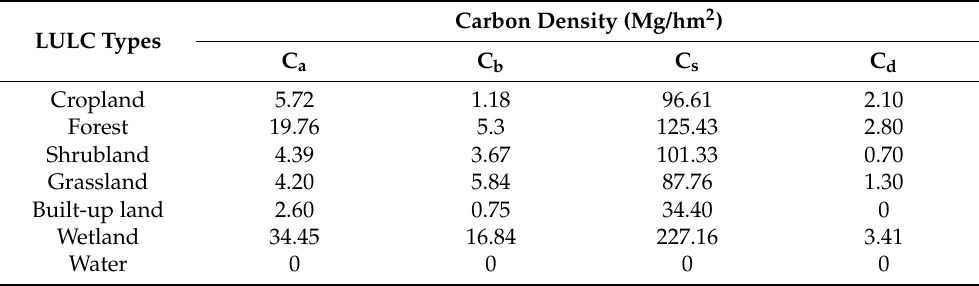
Table 2. Carbon density of each LULC type in Hainan Island (C a —aboveground carbon density, C b — belowground carbon density, C s —soil organic carbon density, and C d —dead organic carbon density).